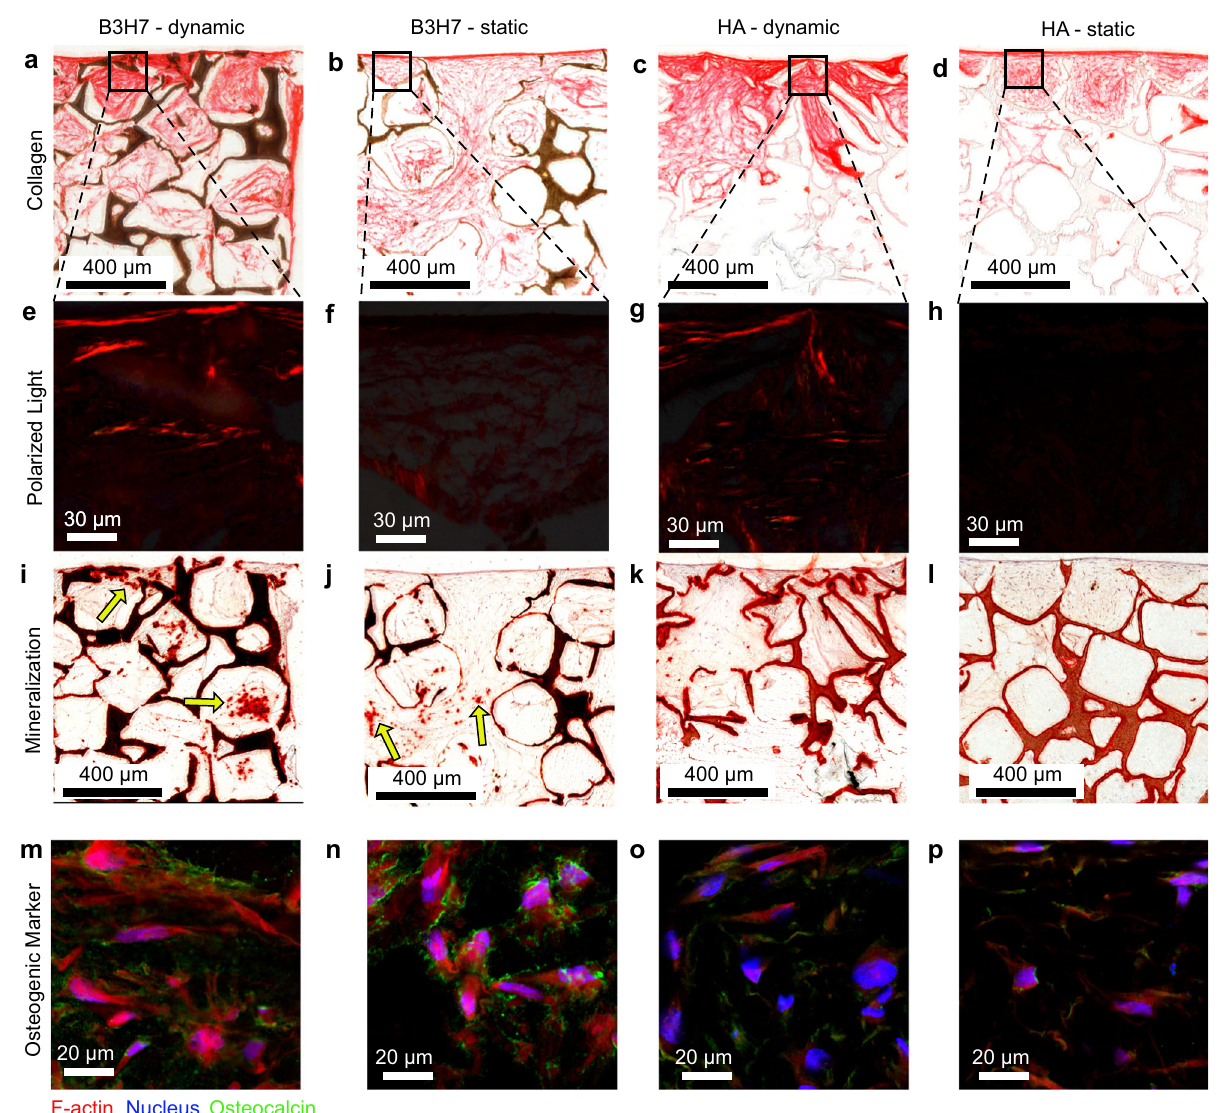
Fig. 6 Extracellular matrix (ECM) products in response to cyclic loading. a – d collagen in red as stained by Picro Sirius Red in B3H7 scaffolds under dynamic, static, and HA scaffolds under dynamic as well as static conditions. The scaffold structures were stained brownish to black. e – h Birefringent collagen fi brils of marked regions in a – d . i – l Mineralized ECM stained by Alizarin Red. Arrows ( i , j ) point to mineral clusters formed in pores. m – p Immunostaining images of F-actin, nucleus, and